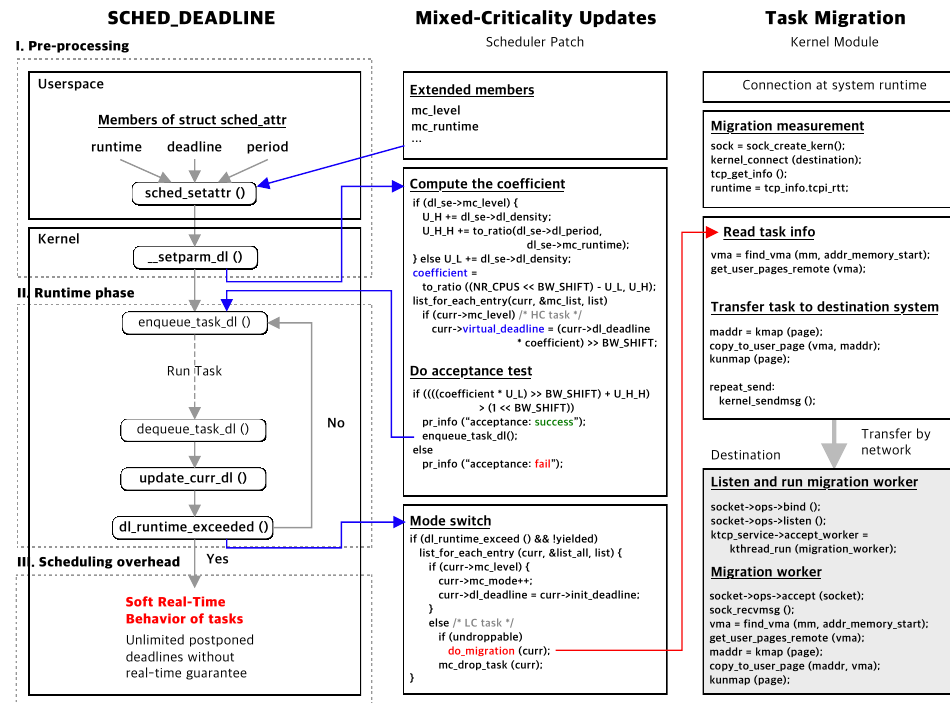
Figure 5. Structure of our distributed system-level